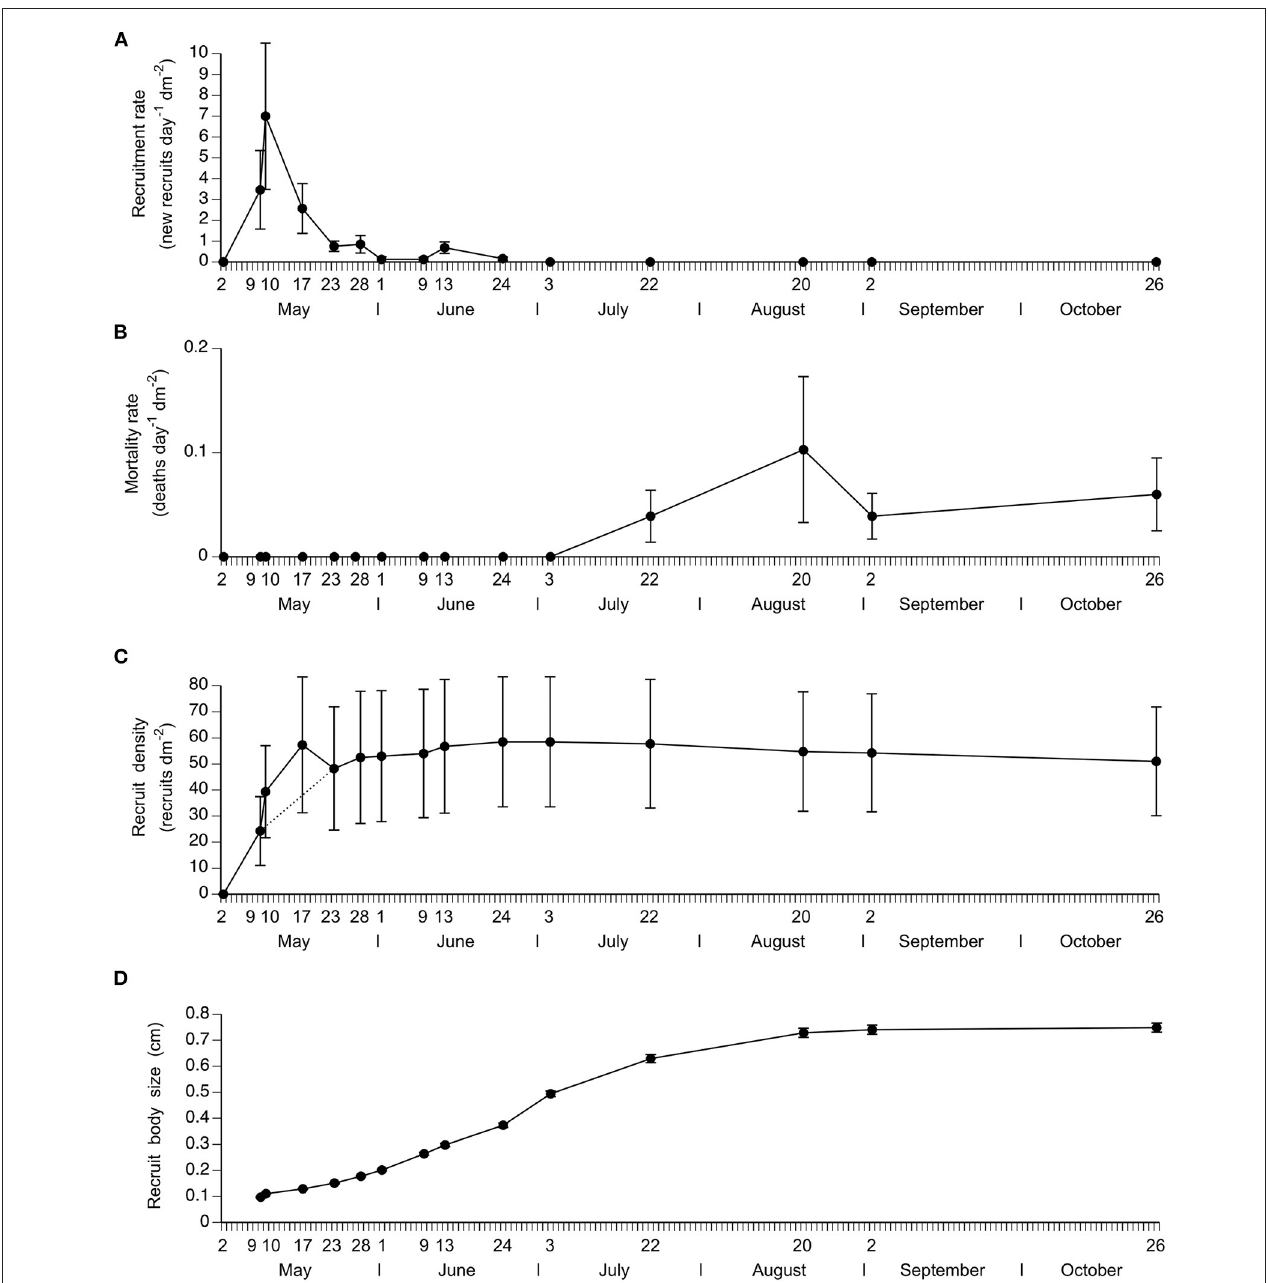
FIGURE 2 | Temporal change (mean ± SE) in (A) barnacle recruitment rate (number of recruits appeared on the substrate since the previous sampling date expressed per day and per unit area), (B) mortality rate of recruits (number of dead recruits appeared on the substrate since the previous sampling date expressed per day and per unit area), (C) recruit density (number of live recruits per unit area), and (D) barnacle body size (basal shell diameter of live recruits).